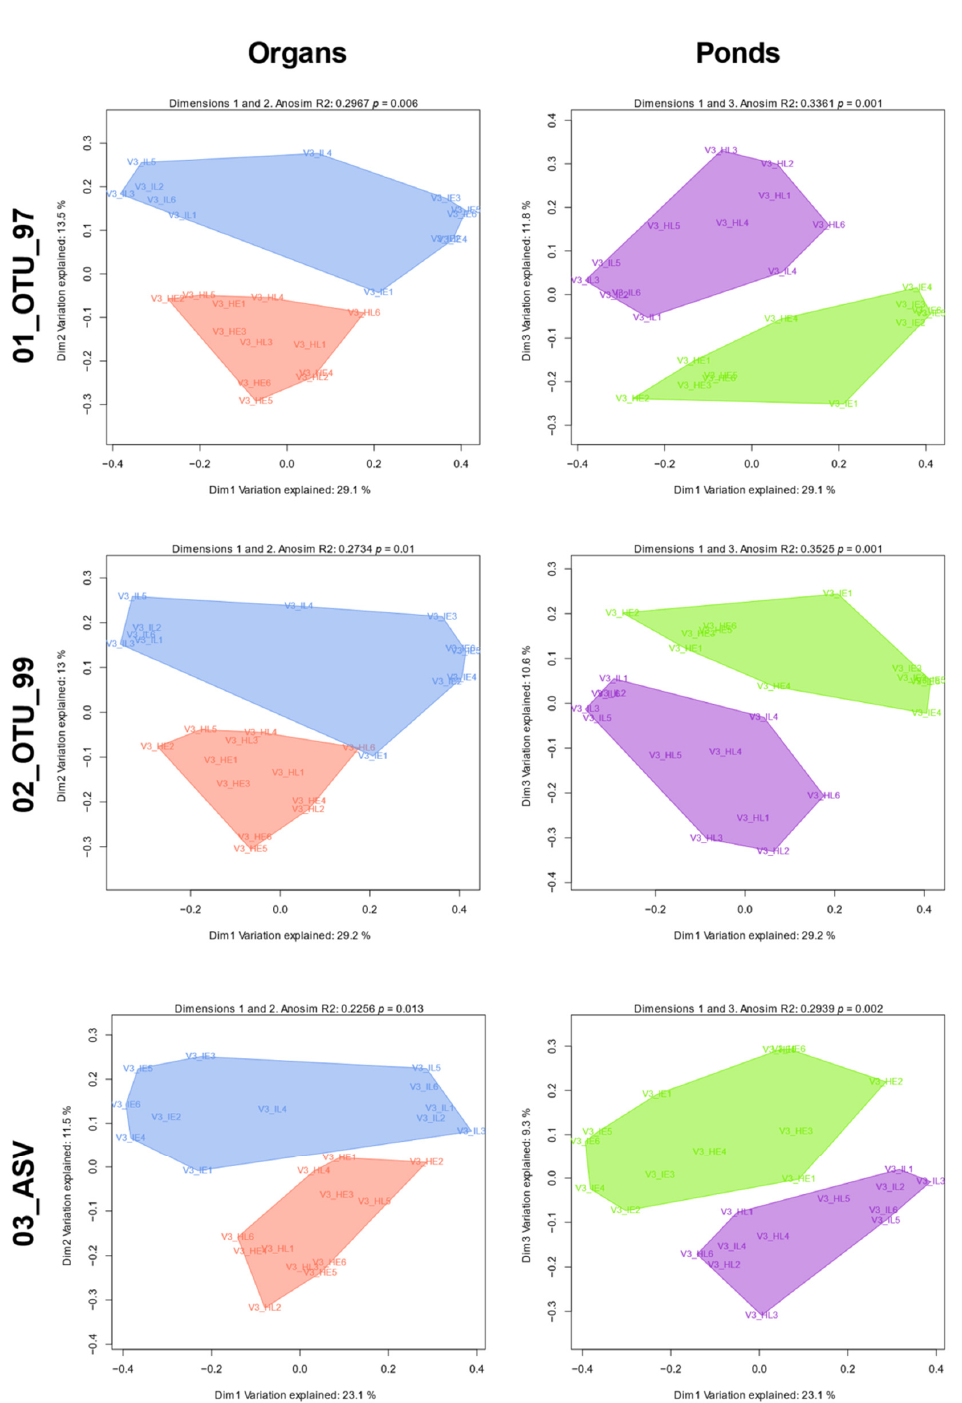
Figure 8. PCoA plots from phylogenetic-based composition set differences. Each 2D plot displays two of the first three linear clusters’ (OTU or ASV) combinations that best separate samples by each group configuration as derived from unweighted UniFrac (presence/absence) distance matrices per set. Polygons are shown per organ or pond but do not reflect actual clusters. Blue: Intestine; Coral: Hepatopancreas; Green: Pond F3; Violet: Pond R2.